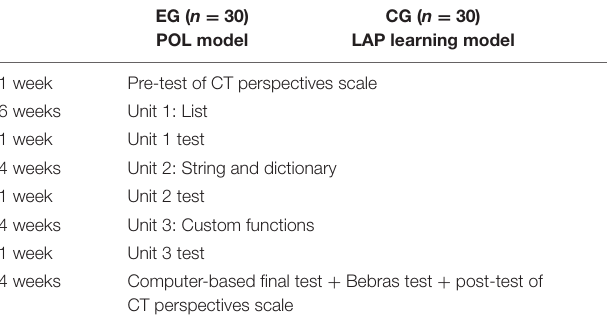
TABLE 3 | Experimental